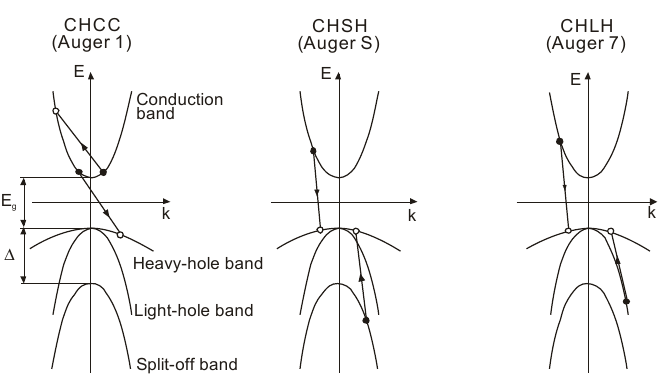
Figure 16. The three BtB Auger recombination processes. Arrows indicate electron transitions; • , occupied state; ○ , unoccupied state.